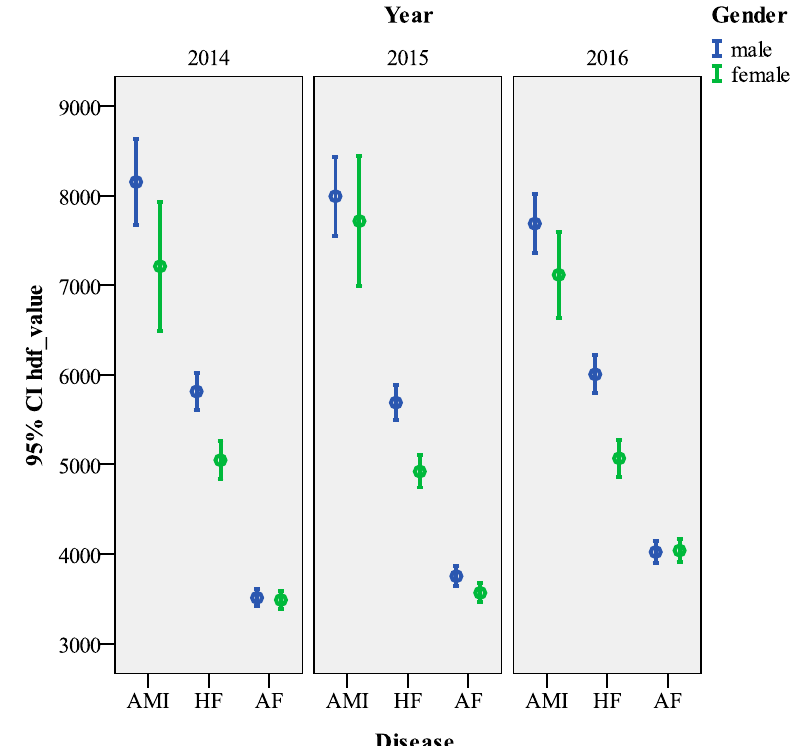
Figure 2. Errorbar chart hdf_value by single disease and gender (95% CI).